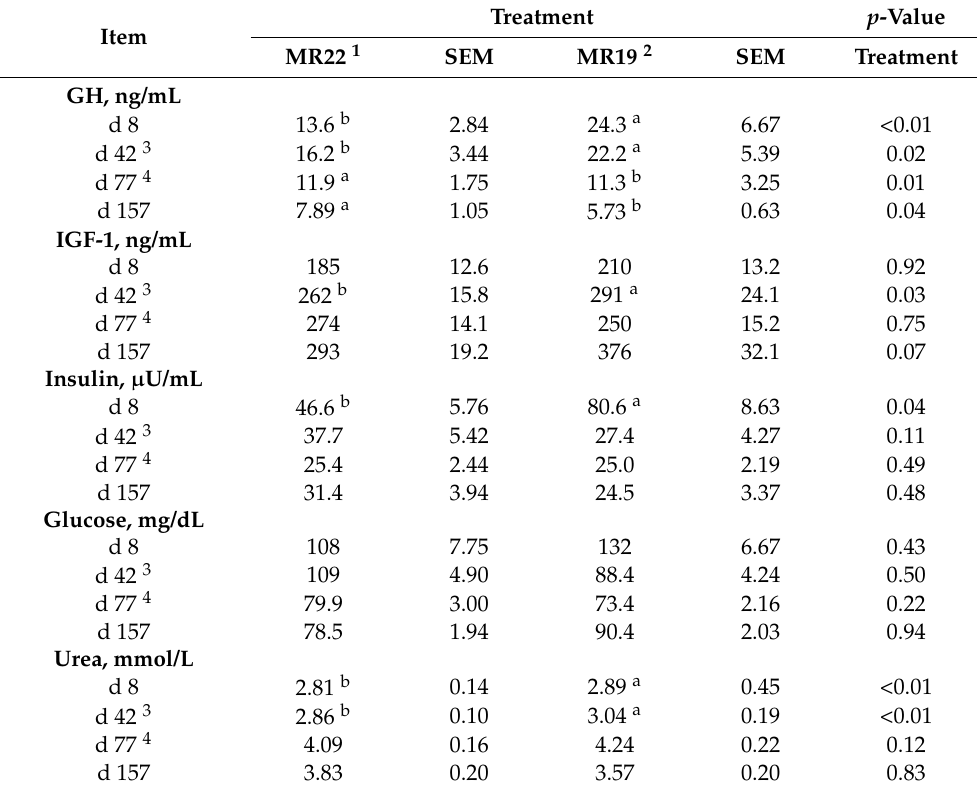
Table 7. Serum levels of growth hormone (GH), insulin-like growth factor 1 (IGF-1), insulin, glucose, and urea depending on age and crude protein content of MR (mean ±